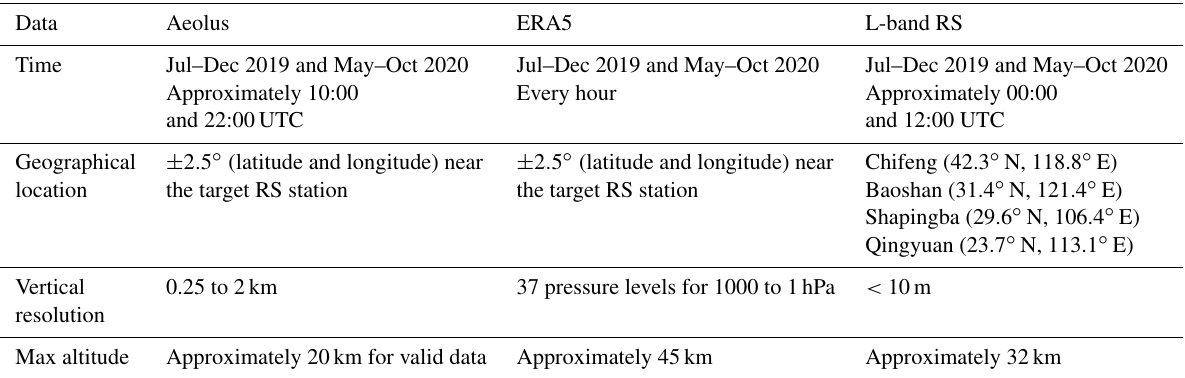
Table 1. Main characteristics of the datasets used in the